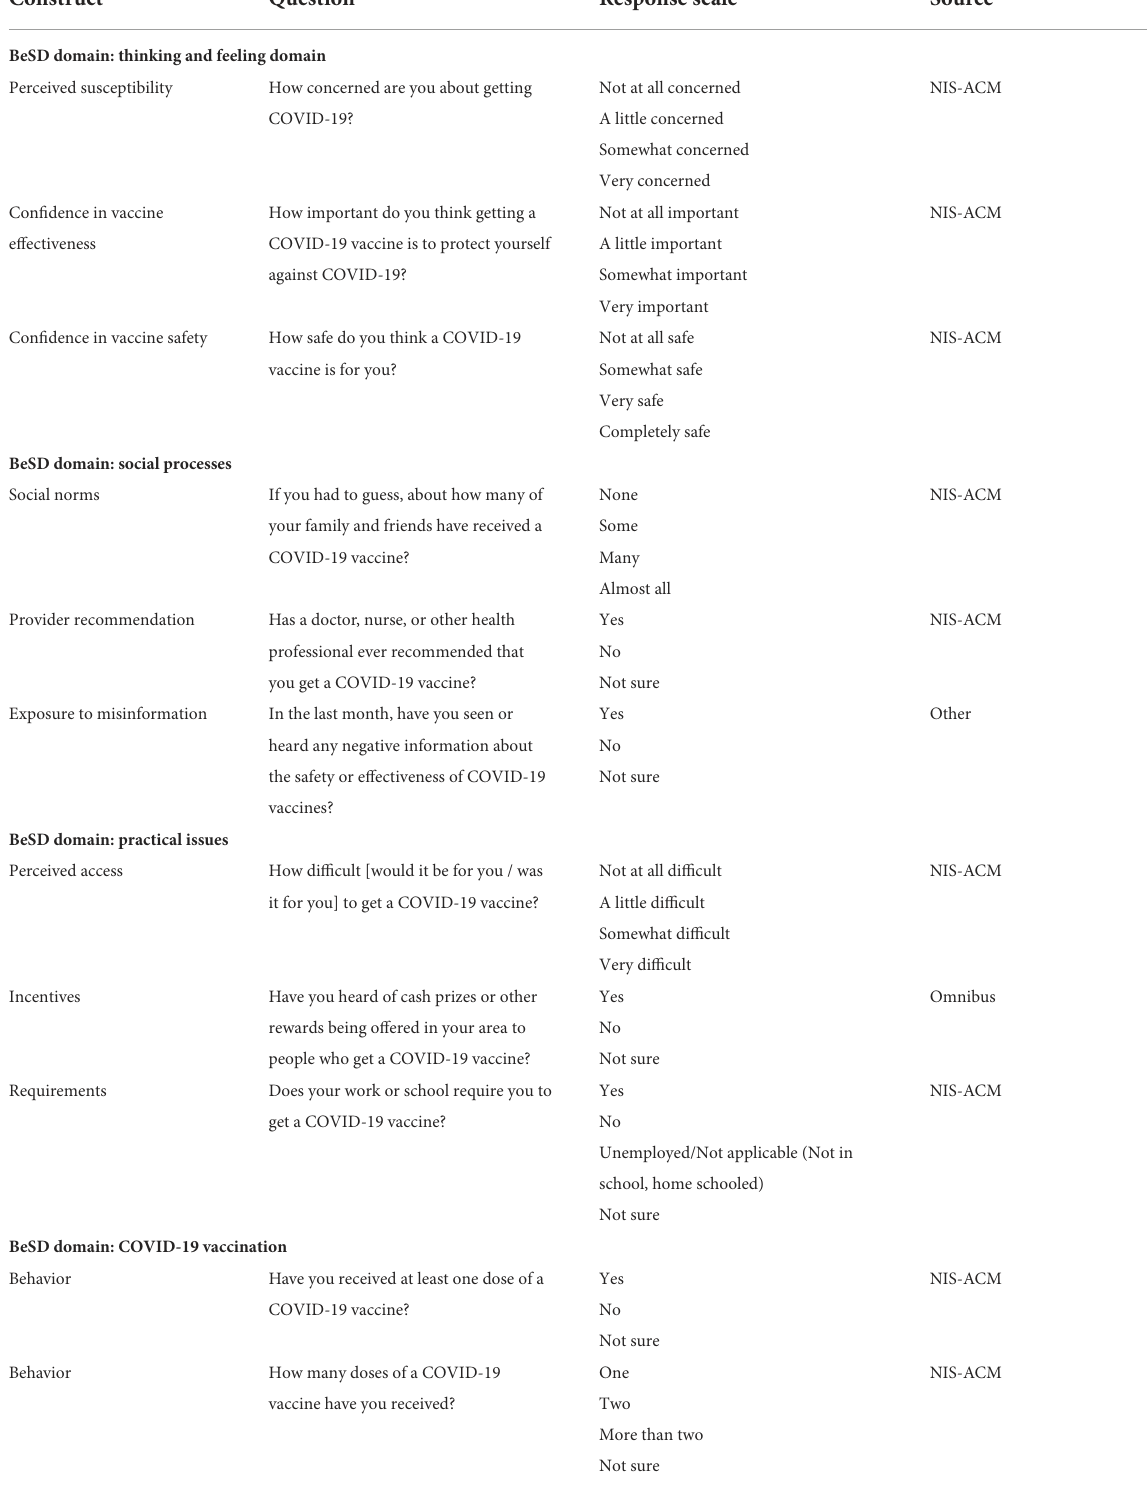
TABLE 2 CDC core survey